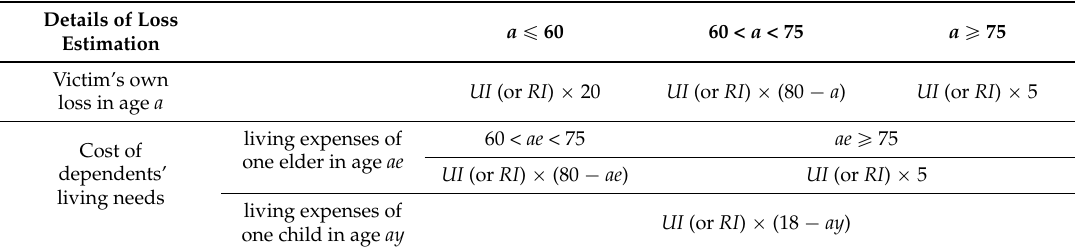
Table 1. The details of evaluating one fatal victim (unit: